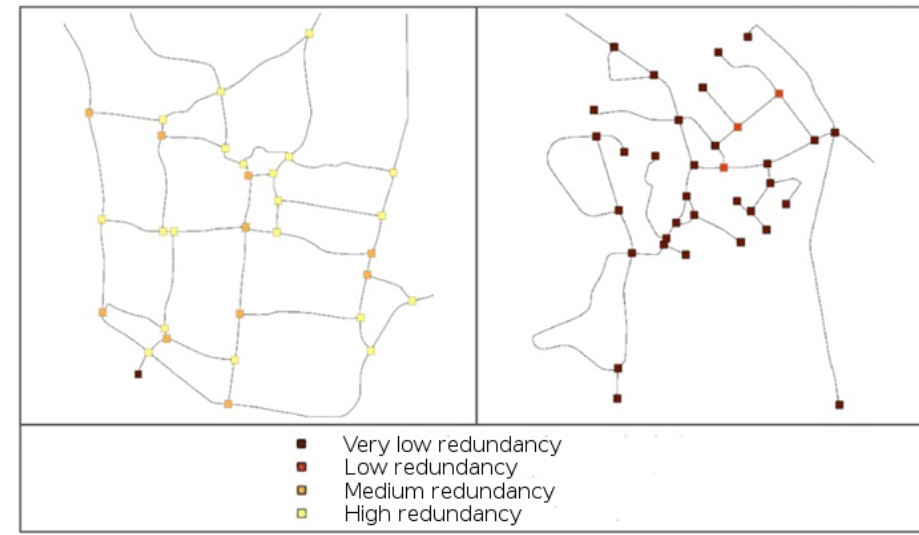
Fig. 5. Orleans road networks redundancy; the city of Bou (left) and the city of Chanteau (right).